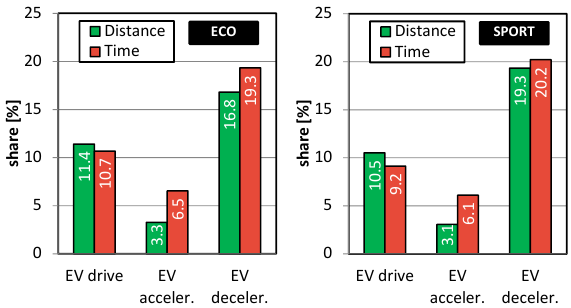
Fig. 17. The share of electric drive mode use relative to time and distance travelled with a hybrid drive system in two driving modes